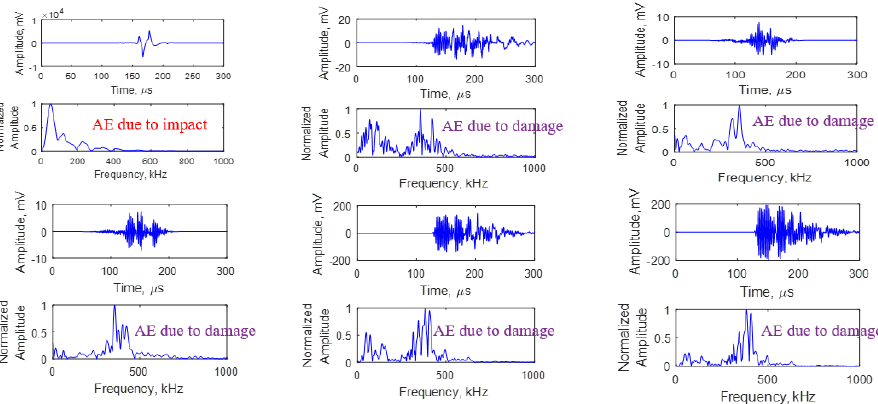
Figure 13. Signal correspondence at all four PWAS due to a hit corresponding to damage formation.